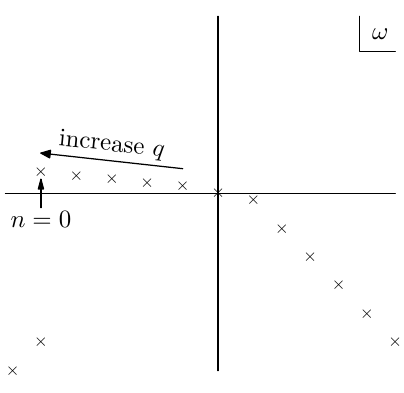
Figure 2 . Schematic plot of the poles of the Green’s function when q is